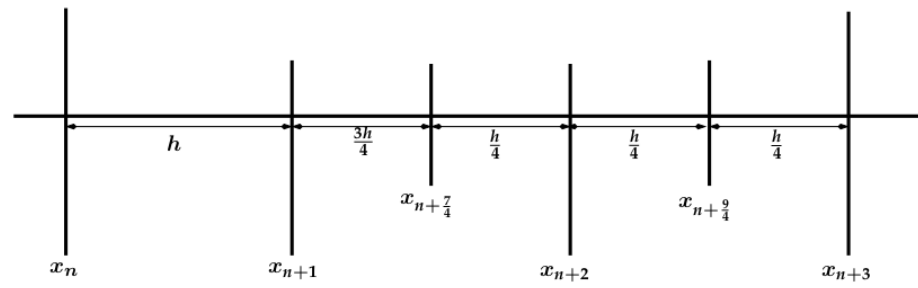
Figure 1. Unequally spaced grid points that led to ill-conditioning (Not drawn to scale).